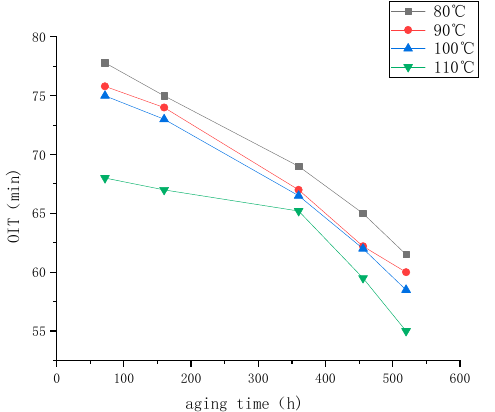
Figure 5. Relationship between the oxidation induction time and the aging time (PE80, 0 MPa).